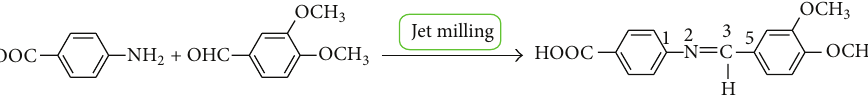
Scheme 1: Synthesis of SBDA.